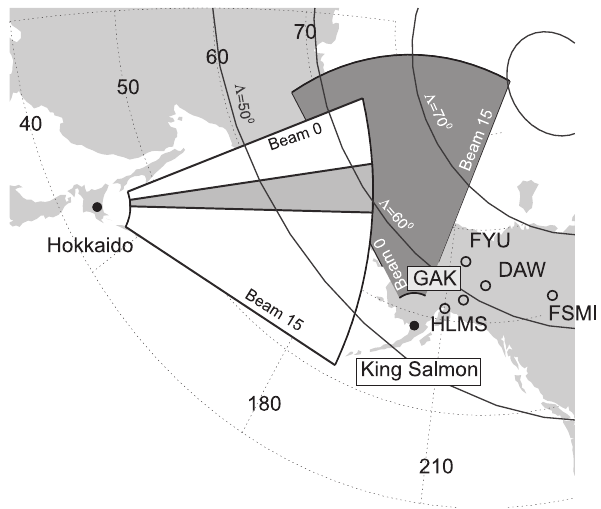
Fig. 1. Fields of view of the Hokkaido (between 400 and 3550km) and King Salmon (between 400 and 2800km) SuperDARN radars and locations of magnetometers in the Alaskan sector of the Arctic. Information on magnetometers is given in Table 1. The dark shaded sector within the Hokkaido field of view indicates the orientation of beams 4–6 statistics for which is presented in this